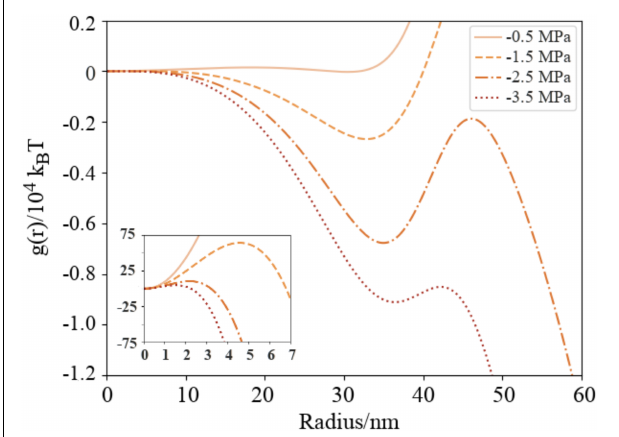
FIGURE 6 | Naïve Gibbs free energy surfaces (Equation 7) for DGDG as a function of external (negative) pressures in a nanobubble with varying radius, presented in units of 10 4 k B T. P external = -0.5 MPa (solid line), − 1.5 MPa (dashed), − 2.5 (dash-dotted) and − 3.5 (dotted). Insert figure shows cavitation free energy barriers in the region r = 0–7 nm in units of k B T . Color scheme is the same as Figure 5 .